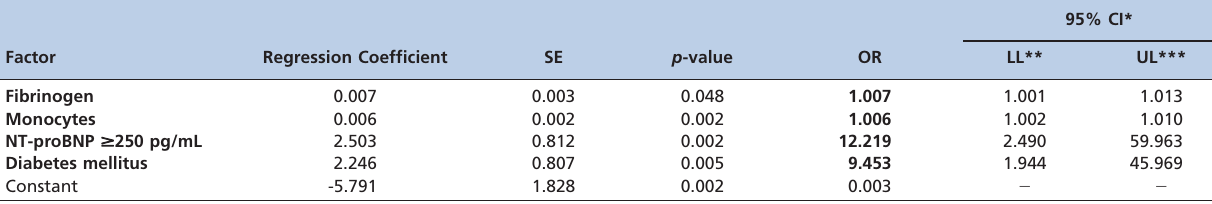
Table 6 - Multivariate logistic regression analysis of angiographic coronary atherosclerosis - estimation of odds ratios in the presence of diabetes mellitus, N-terminal fragment of pro-B-type natriuretic peptide level . 250 pg/mL, increased fibrinogen concentration and increased monocyte count.